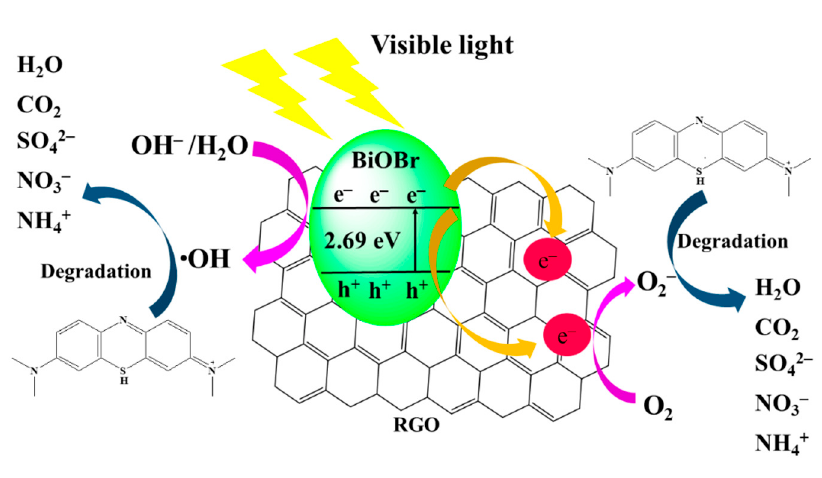
Figure 9. The photocatalytic mechanism diagram.